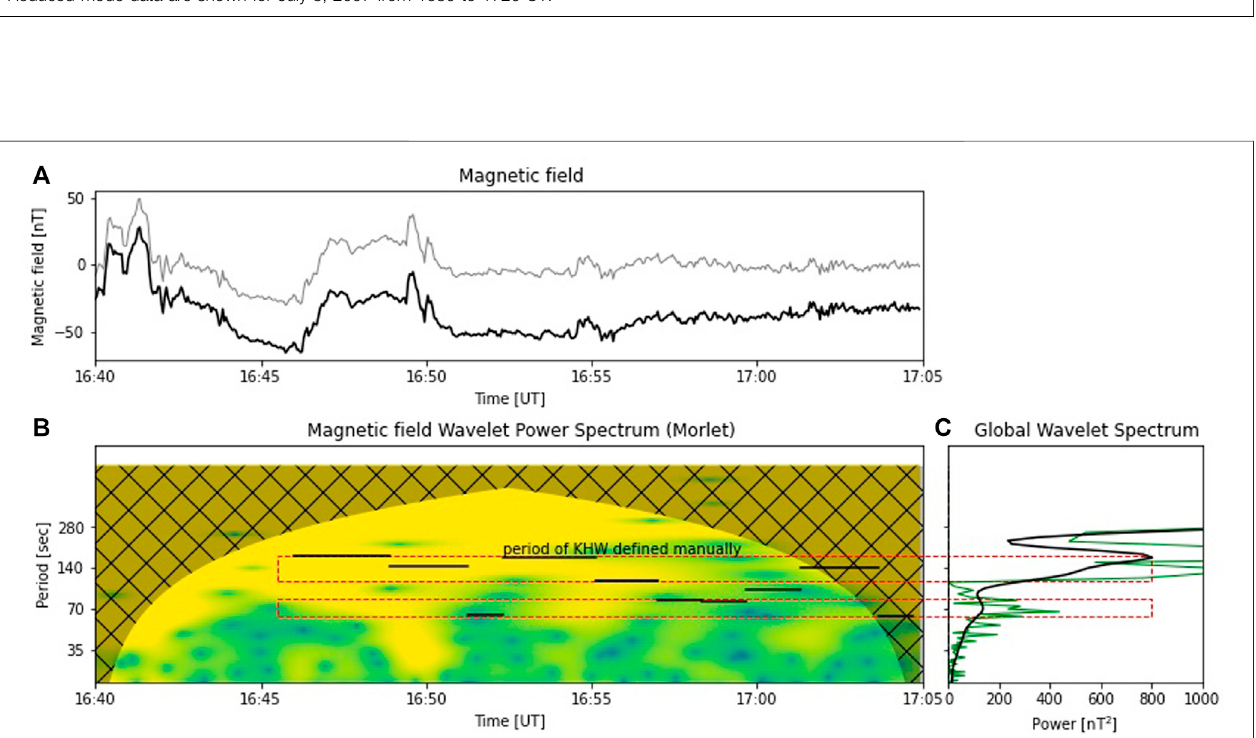
FIGURE 14 | THEMIS-E pressure tensor for the xx − (red), yy − (blue), and zz − components (green), eV cm − 3 , recorded by the Electrostatic Analyzer (ESA). Reduced mode data are shown for July 3, 2007 from 1630 to 1720 UT.